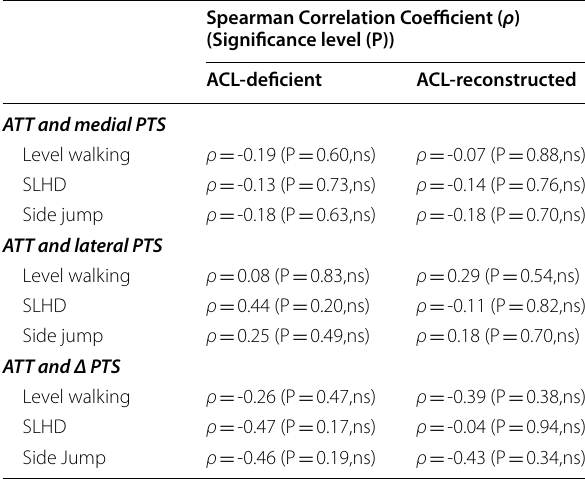
ACL Anterior cruciate ligament, SLHD Single-leg hop for distance, SD Standard deviation, PTS Posterior tibial slope, ns Non-significant